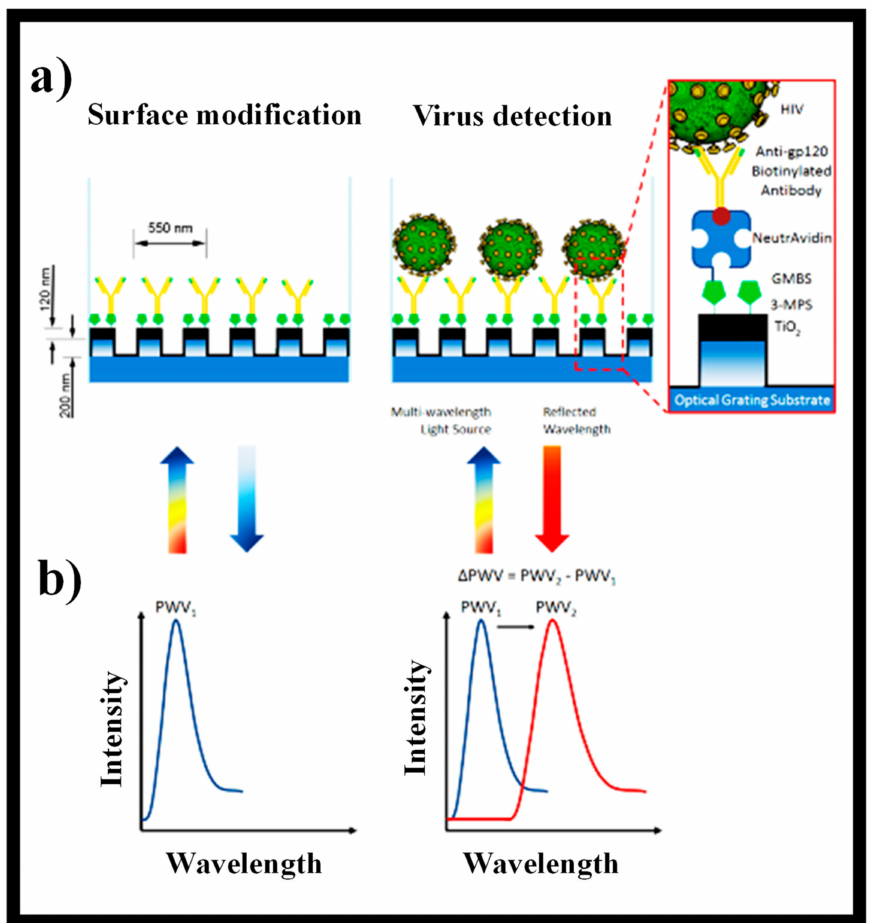
Figure 12. Schematic of PhC-based virus recognition platform. ( a ) The bottom surface of PhC biosensor microplate wells is made up of a nanostructured subwavelength grating that is covered with TiO 2 . Reprinted from ref. [211]; ( b ) binding occurrences inside the immediate proximity of the sensing area alter the bulk RI; therefore, the peak wavelength value (PWV) of the reflected light is changed. The swing in the peak wavelength (DPWV) is in direct proportion to the attachment of molecules and/or bioagents onto the biosensing surface Reprinted from ref.